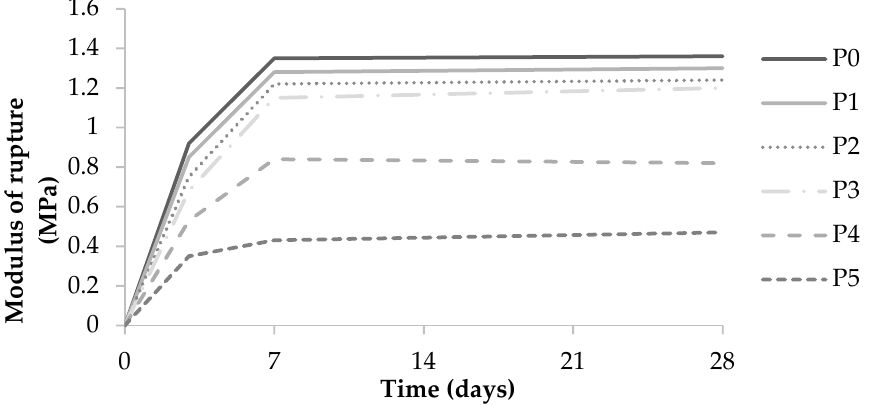
Figure 4. Evolution of the modulus of rupture in bending of WCAP as a function of the moist curing duration.